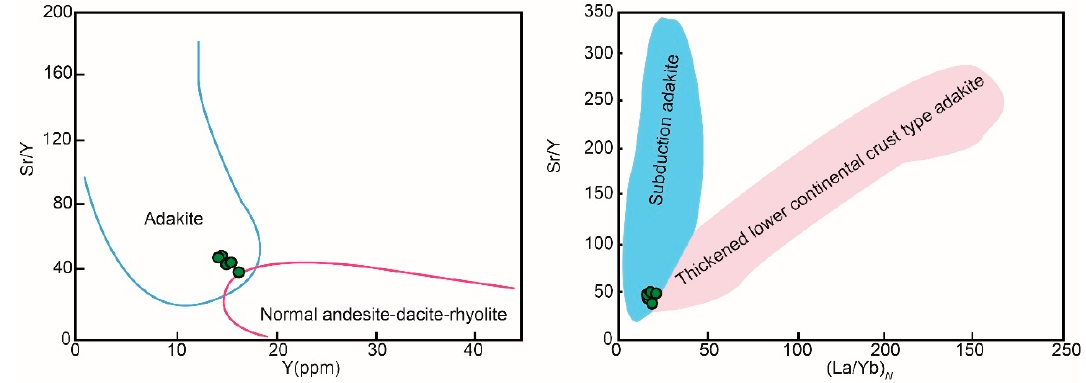
Figure 11. ( a ) Sr/Y–Y and ( b ) Sr/Y–(La/Yb) N for Hucunnan granodiorite [61]. Figure 11. ( a ) Sr / Y–Y and ( b ) Sr / Y–(La / Yb)